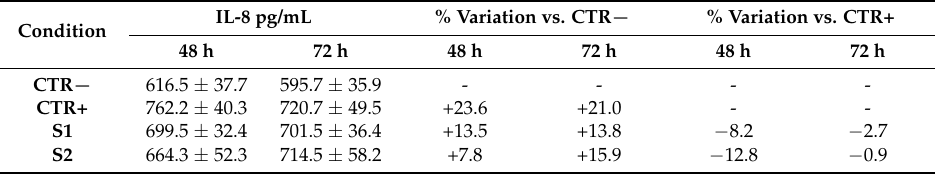
Table 4. IL-8 levels in CTR − , CTR+, S1 and S2 tissues assessed at 48 and 72 h by ELISA test. IL-8 Condition